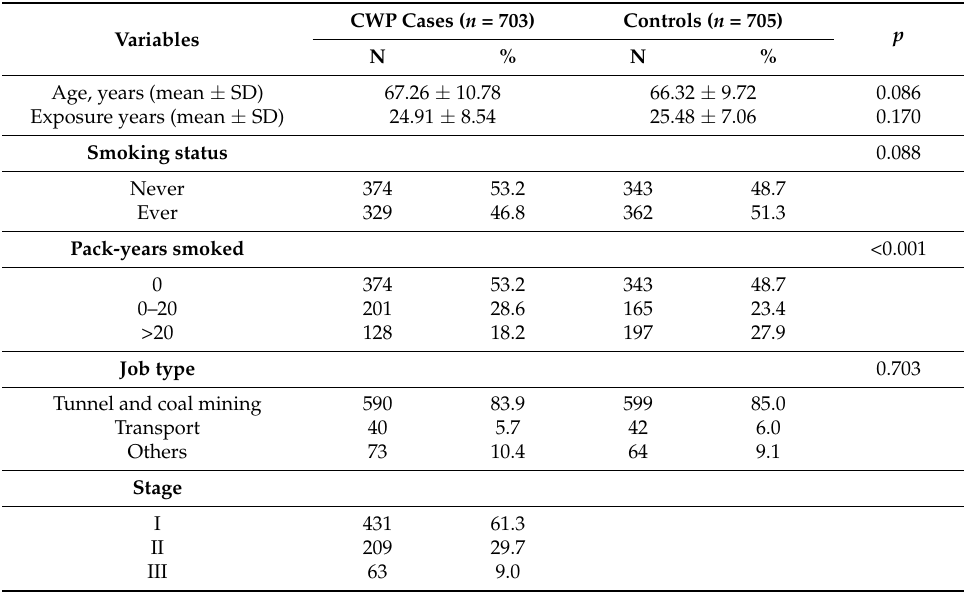
Table 1. Demographic and selected variables among the coal workers’ pneumoconiosis (CWP) cases and